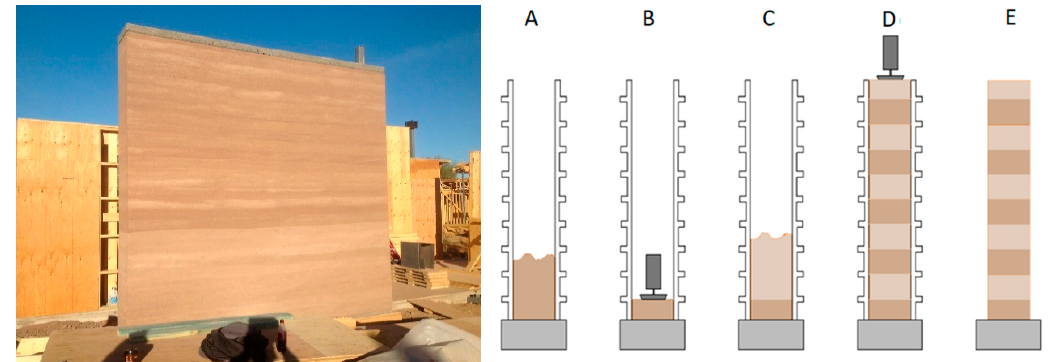
Figure 1. Right: a cement stabilized rammed earth (CSRE) wall. Left: CSRE wall erection scheme. A: the formwork is filled with a layer of moist soil-cement mixture. B: ramming the mixture. C: filling the formwork with another layer of the mixture. D: successive layers of moist mixture are added and compacted. E: the formwork is removed.